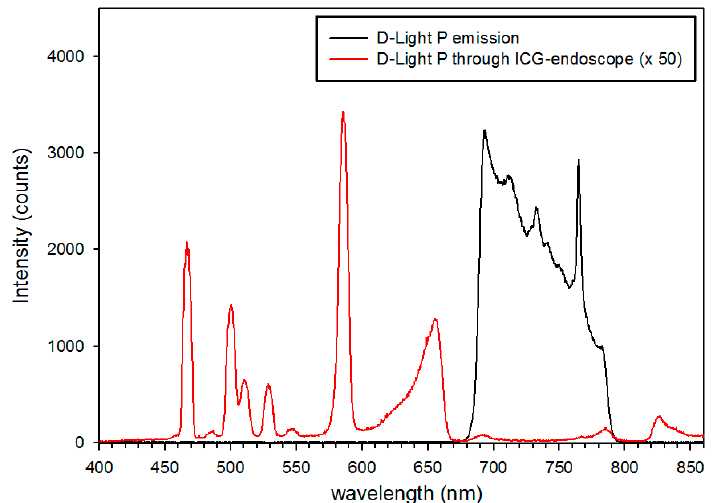
Figure 5. Light spectra emitted from the illumination fibers of the endoscope with the light source in NIR mode (black line) and transmitted through the eyepiece of the endoscope with the endoscope directed to a non-fluorescent reflectance standard (red line). Note: the emission at 465 nm was later removed by a longpass filter.